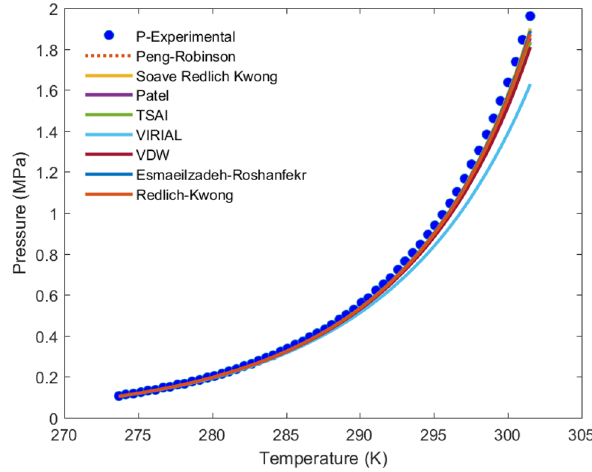
Fig. 8 Predicted pressure versus experimental plot for L region, AAD %, [Min/Max] of [2.1/5.1]